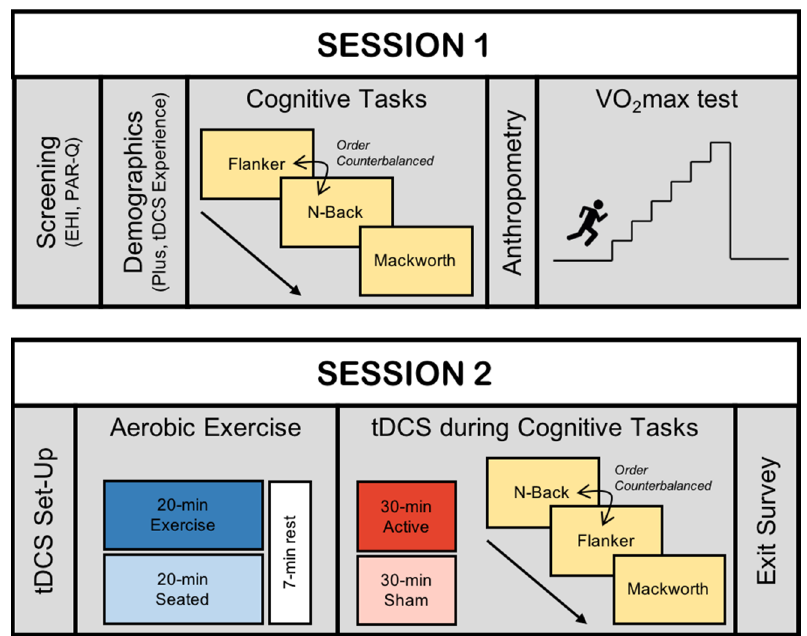
Figure 1. Overview of the timeline of activities at each experimental session. Session 1 activities appear in the top panel and Session 2 activities appear in the bottom panel. tDCS = transcranial direct current stimulation.